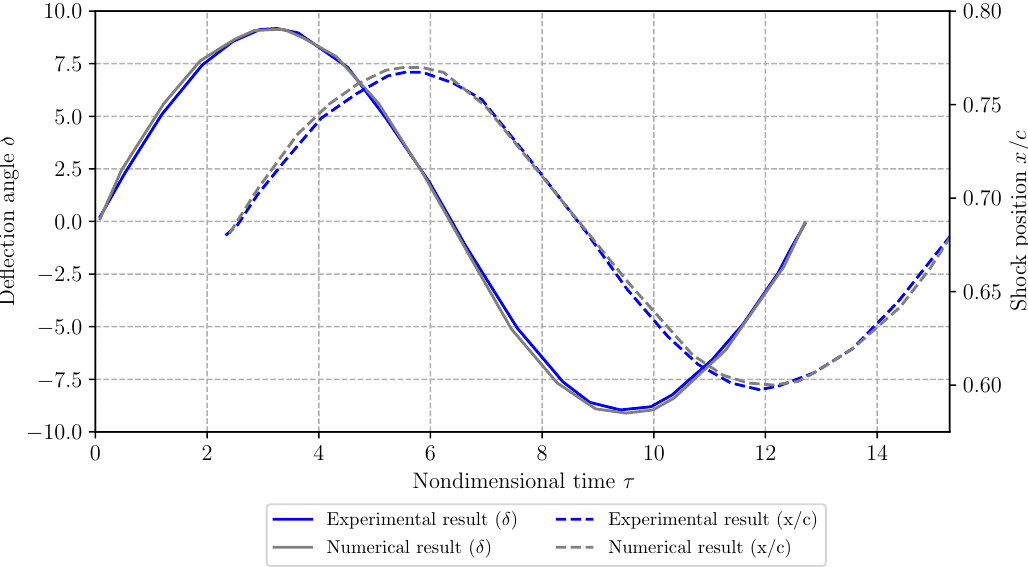
Figure 4. Comparison of numerical and experimental results in terms of varying aileron angle and shock position with time (NACA65 1 213 airfoil, Ma ∞ = 0.8, Re = 20.7